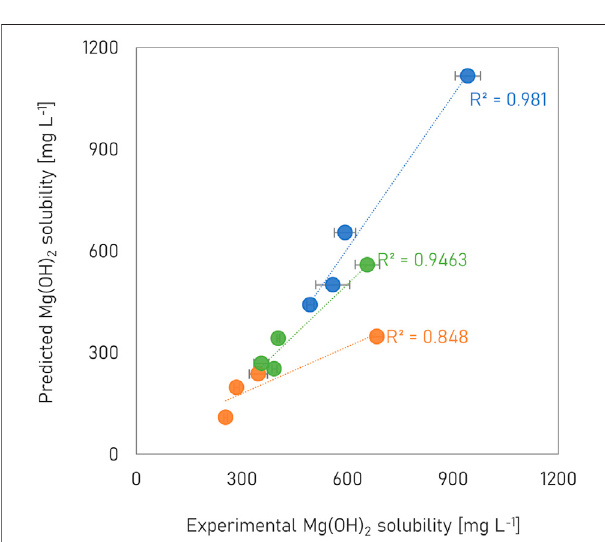
FIGURE 6 | The experimentally determined solubility and the simulated solubility of Mg(OH) 2 in real fresh urine (blue), synthetic fresh urine (orange) and dephosphatisedsyntheticfreshurine(green).Datapointsforexperimentalsolubility are average values of three replicates, with error bars showing the standard deviation. Dashed lines represent linear fi t to the experimental